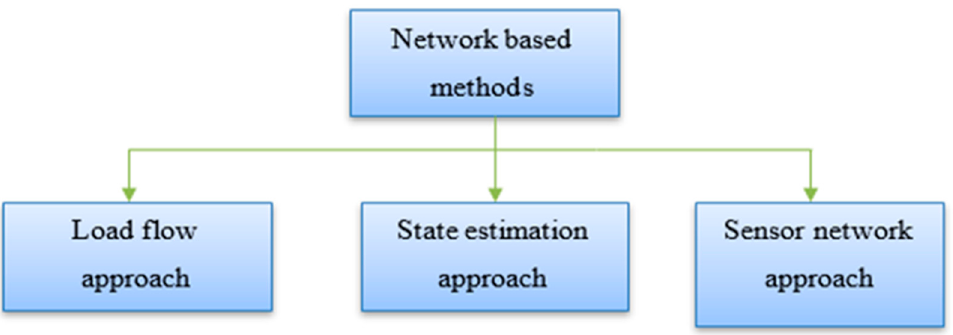
Figure 5. Network-based methods for NTL detection.